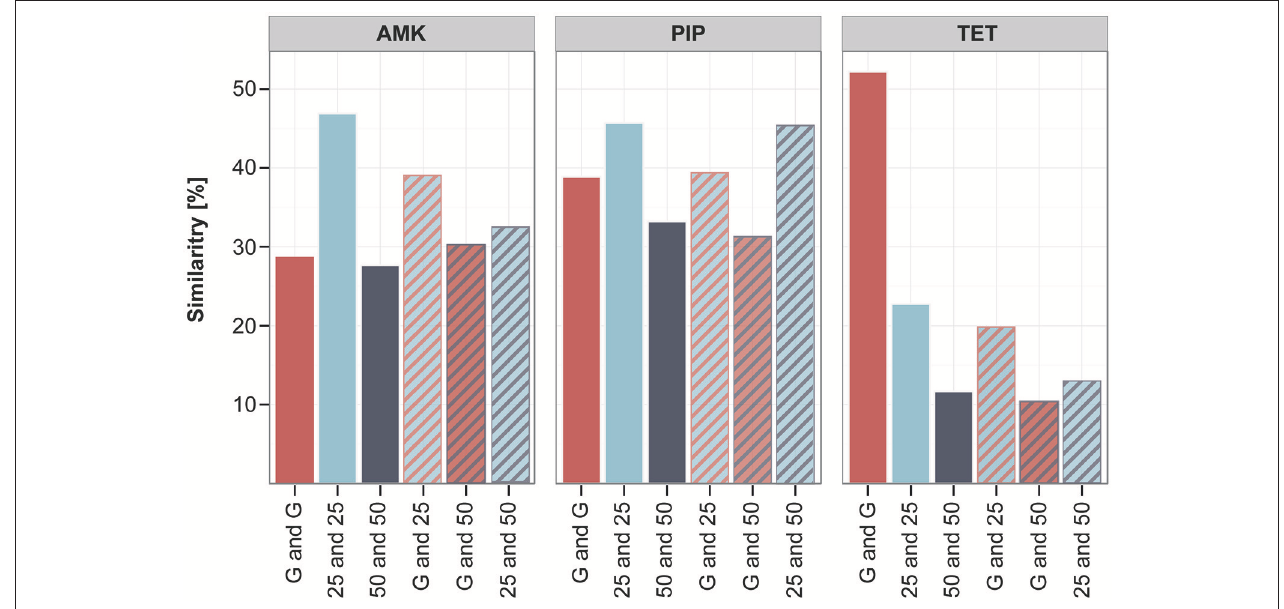
FIGURE 6 | Similarity of lineages evolved to different selection strengths. The similarity between different strains was calculated in pairwise comparisons by analyzing the percentage of genes that were mutated in both strains compared to the total number of mutations found in the two strains. The average of the pairwise similarity is displayed for different groups of strains: either within one experimental setup like the gradient (G) (red) or the increment approaches (25 and 50) (blue and gray) or between those experimental setups (stripes), comparing similarity of the gradient and increment lineages or the increment approaches with each